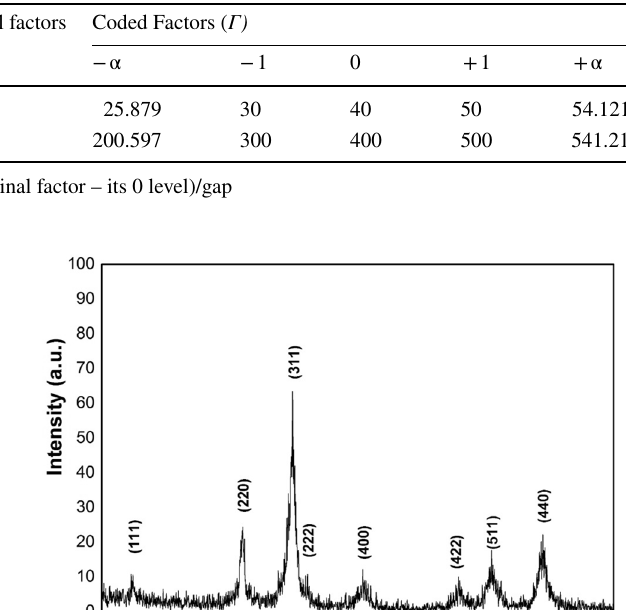
Table 1 Experimental range and levels of the independent factors of central composite design for Synozol Blue oxidation*